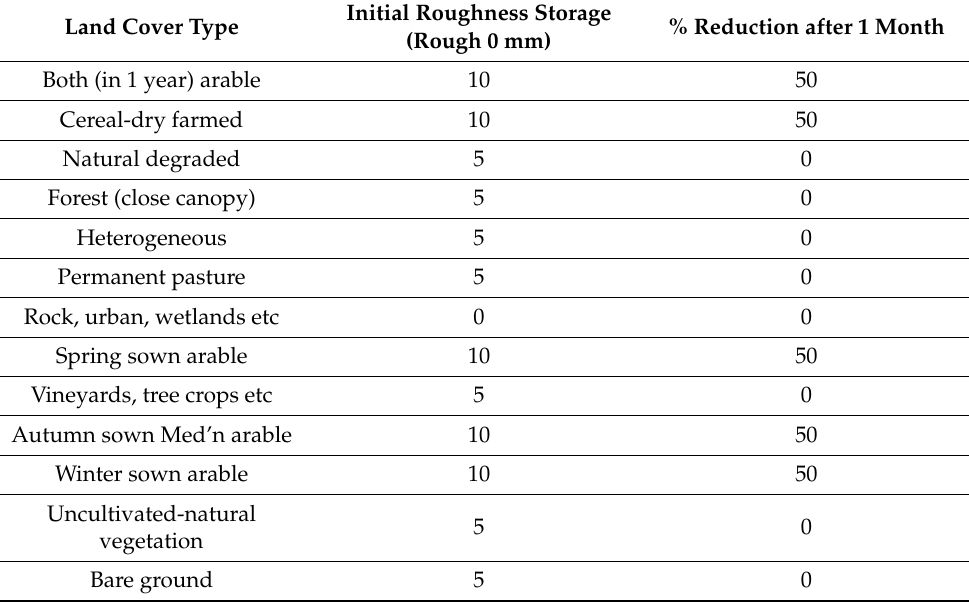
Table A6. PESERA zm estimation according to soil texture class